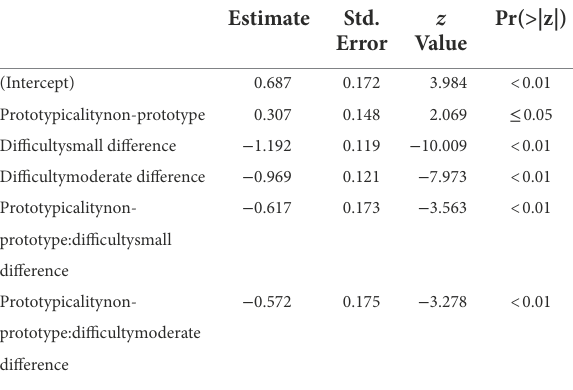
TABLE 5 Summary of the best fitting model for the response accuracy dataset in Experiment